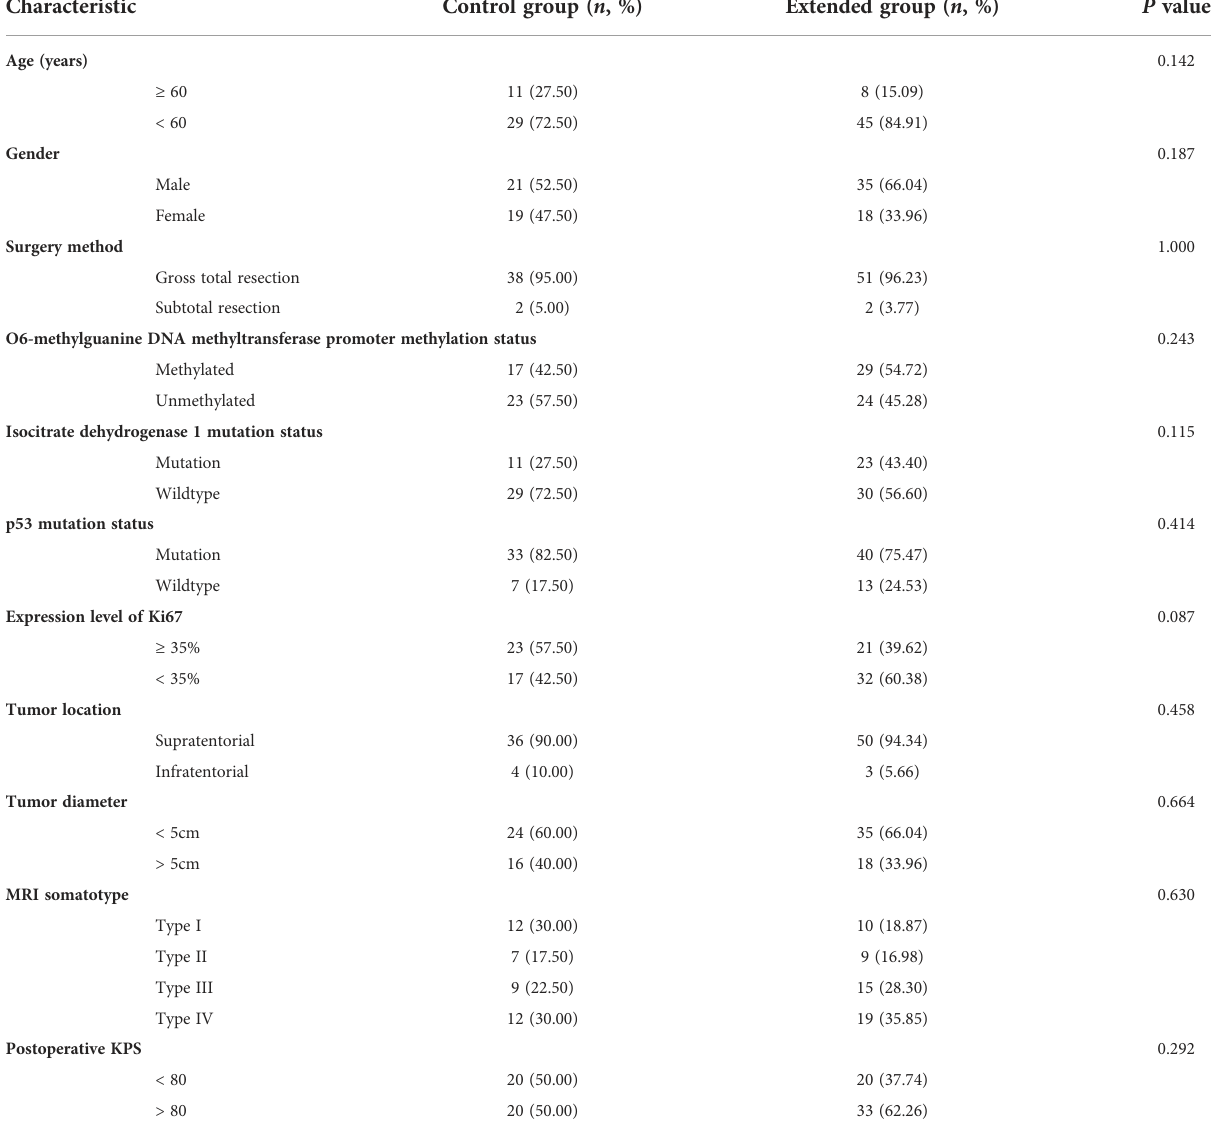
TABLE 1 Basic characteristics of enrolled postoperative patients with newly diagnosed glioblastoma. Characteristic Control group ( n ,